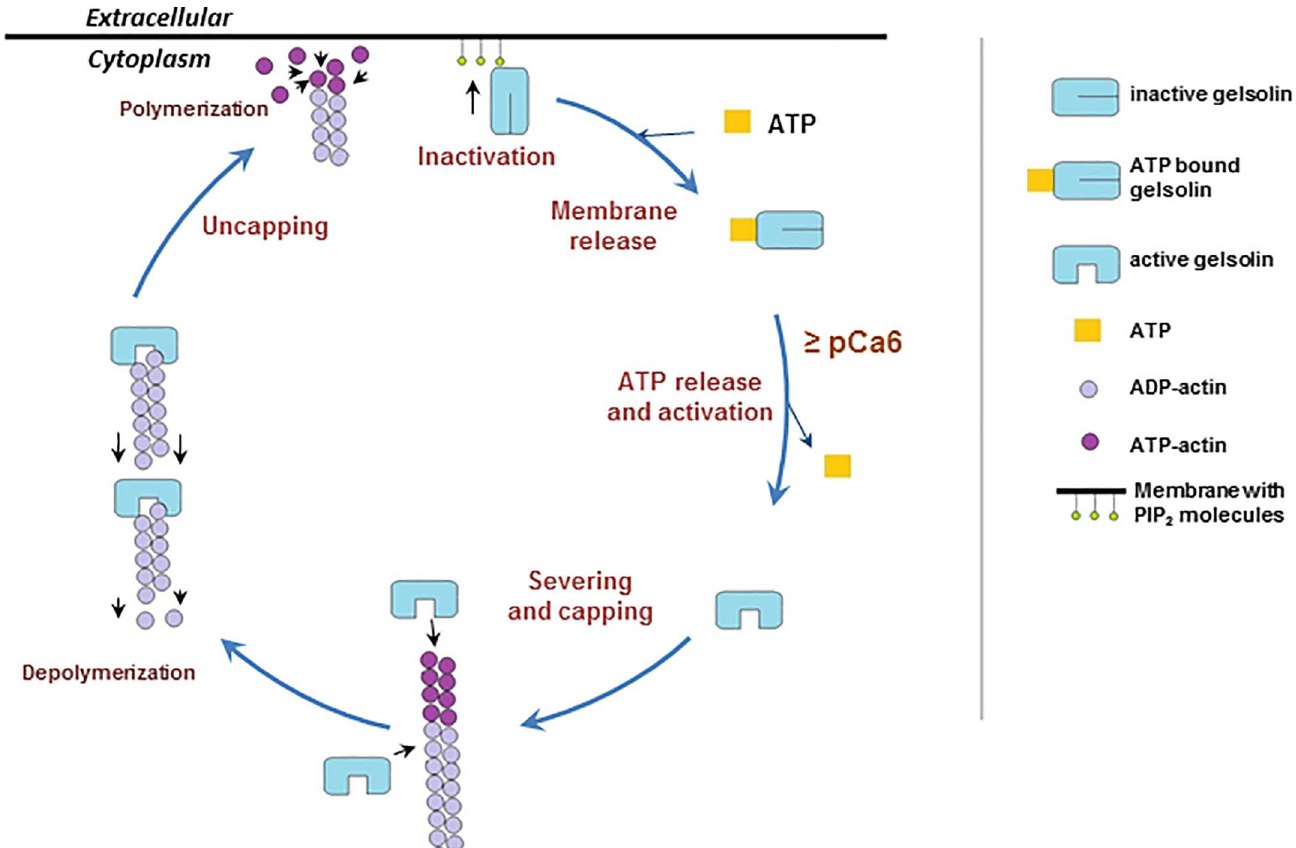
Fig 4. Model of the severing, capping, uncapping and inactivation/release cycle of gelsolin. The cartoon presents a model for the cycle of activation and function of gelsolin. Severing and capping: Elevated free calcium levels activate gelsolin, releasing ATP, leading to severing and capping of actin filaments. Depolymerization: Gelsolin-capped filaments will depolymerize from their pointed ends. Uncapping and polymerization: Gelsolin-capped actin filaments will be uncapped on encountering PIP 2 in the membrane, resulting in force being exerted on the membrane from the polymerization of the uncapped filaments. Inactivation and membrane release: Gelsolin will be released from PIP 2 and the membrane by competition with ATP. Following its release gelsolin is able to undergo subsequent cycles of severing, capping, uncapping and